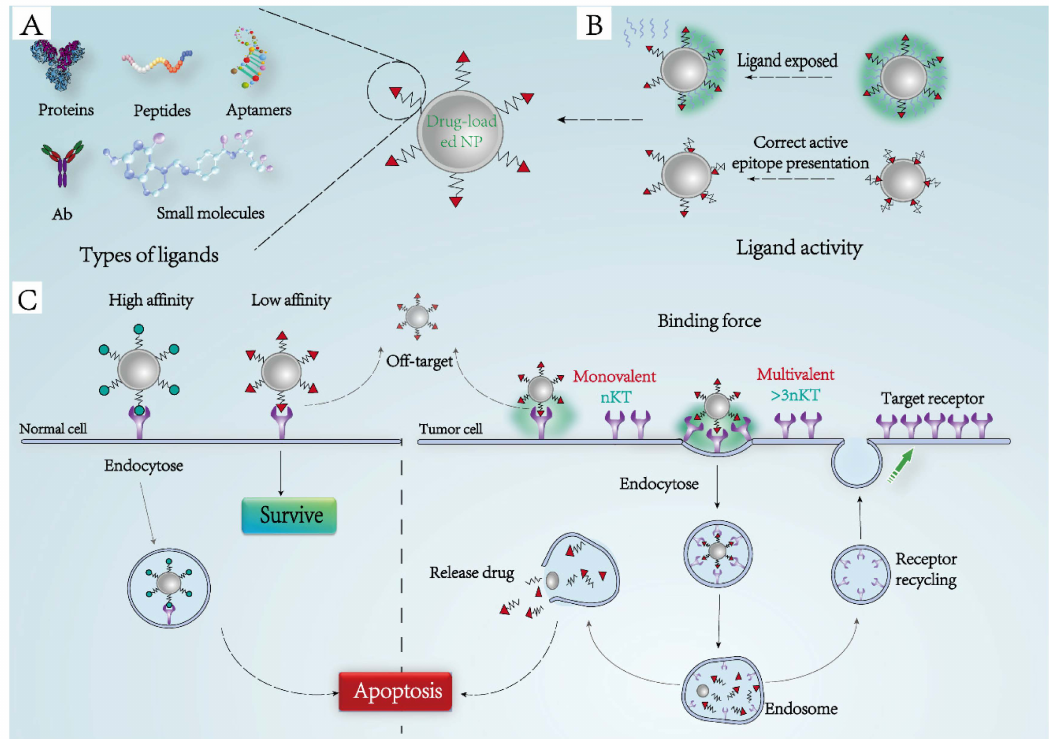
Figure 3. Schematic diagram of ligand-receptor interaction. ( A ) Common types of targeted ligands, including proteins (monoclonal antibodies), artificial peptides, aptamers and small molecules; ( B ) the targeting ability is demonstrated only when the ligand modified on the particle surface is exposed and exhibits the correct epitopes; ( C ) ligand-receptor binding induces endocytosis. Compared with the off-target effect of the low-affinity ligand, monovalent binding of the high-affinity ligand mediates endocytosis of drug-loaded particles and induces apoptosis. Compared with monovalent binding, the multivalent effect can significantly increase the binding force between the ligand and receptor, drive membrane invagination to form the nucleosome and reduce the number of membrane receptors, and then the receptors sprout and form individual vesicles to return to the cell surface to achieve the purpose of receptor recycling (nKT in the figure indicates the monovalent binding strength of ligand and